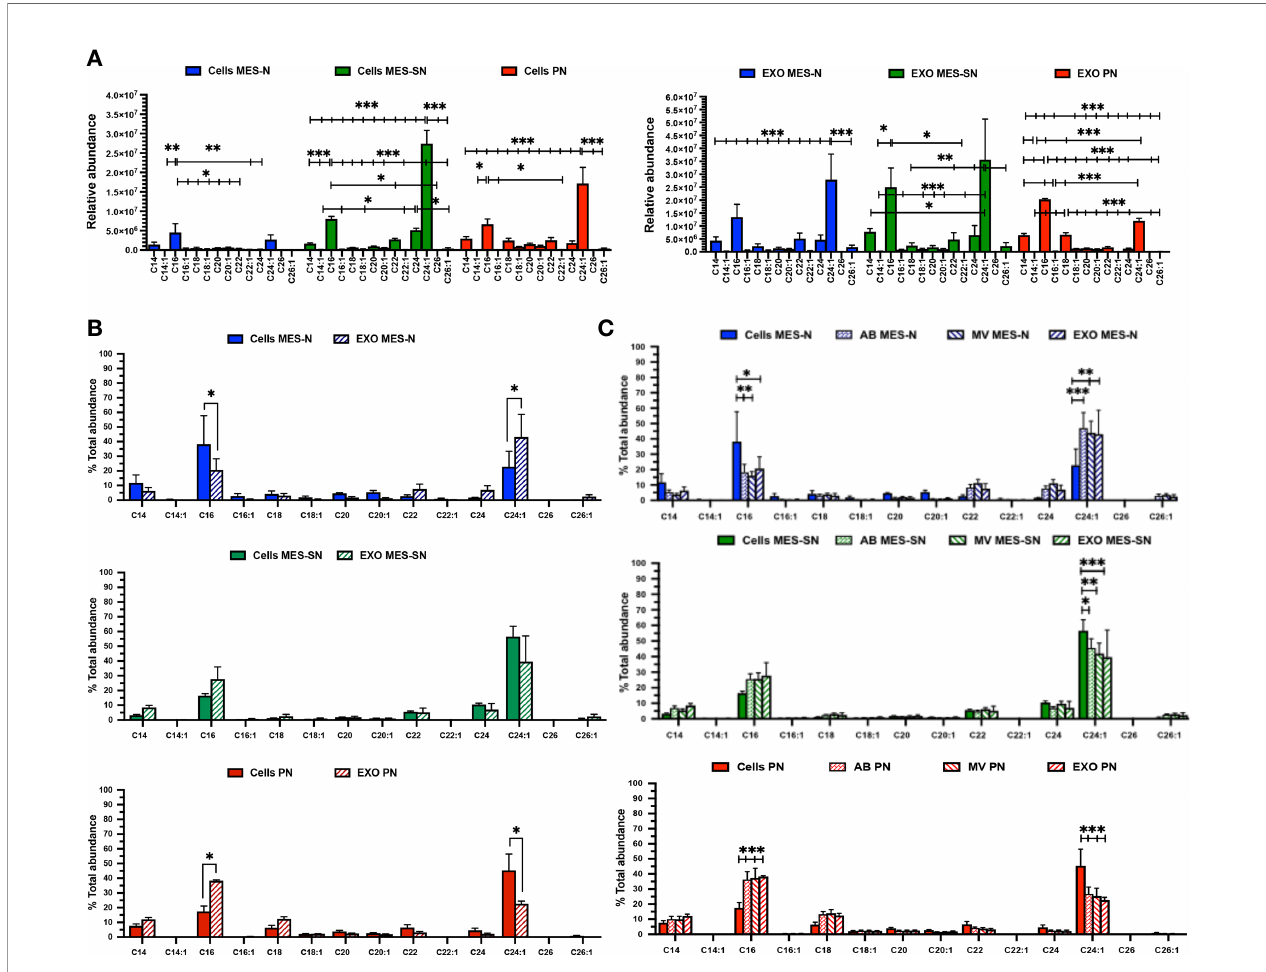
FIGURE 4 | Ceramide pro fi le in cells, exosomes (EXO), MV, and AB for the three GBM phenotypes. (A) Ceramide pro fi le for the three phenotypes for cells and their derived exosomes (EXO). (B) Ceramide distribution between exosomes and their parent cells for each phenotype independently. (C) Ceramide distribution among MV, AB, exosomes, and their parent cells for each phenotype independently. In blue, MES-N phenotype; in green, MES-SN phenotype; and in red, PN phenotype. For all bar graphs, error bars represent the mean ± SEM. *p < 0.05; **p < 0.01; and ***p <